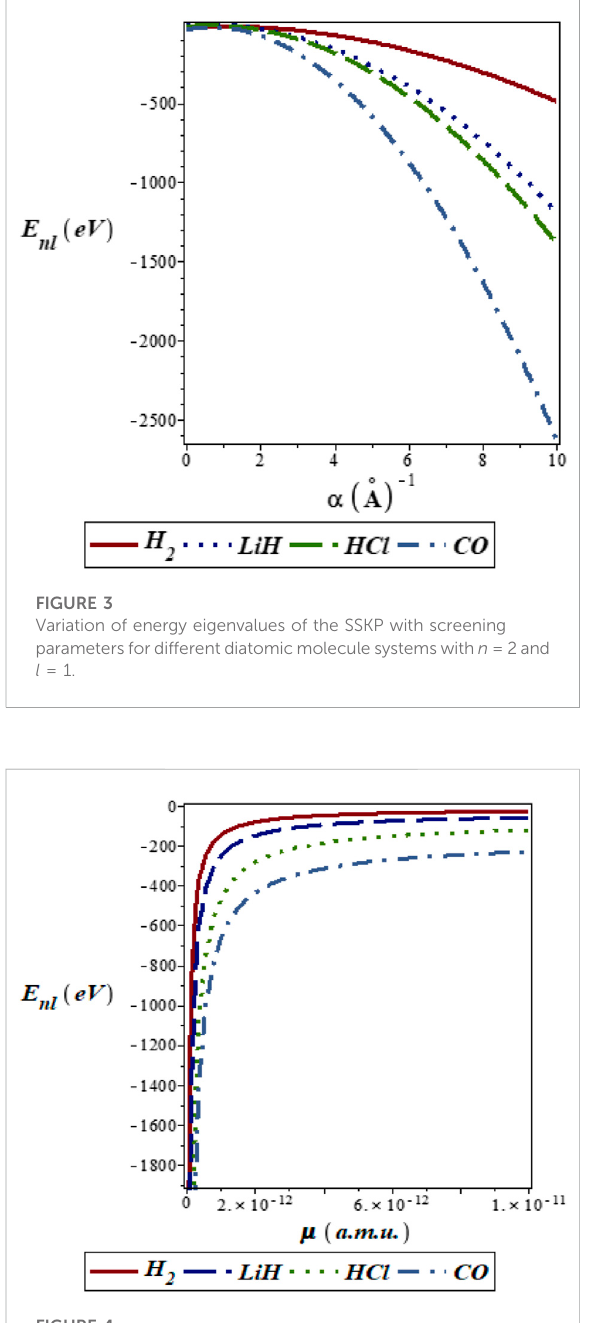
FIGURE 4 Variation of energy eigenvalues of the SSKP with reduced mass for different diatomic molecule systems with n = 2 and l = 1.